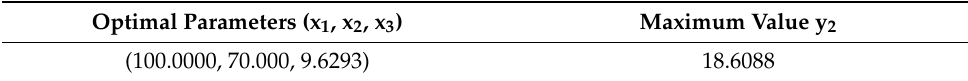
Table 5. The results of the optimization problem for y